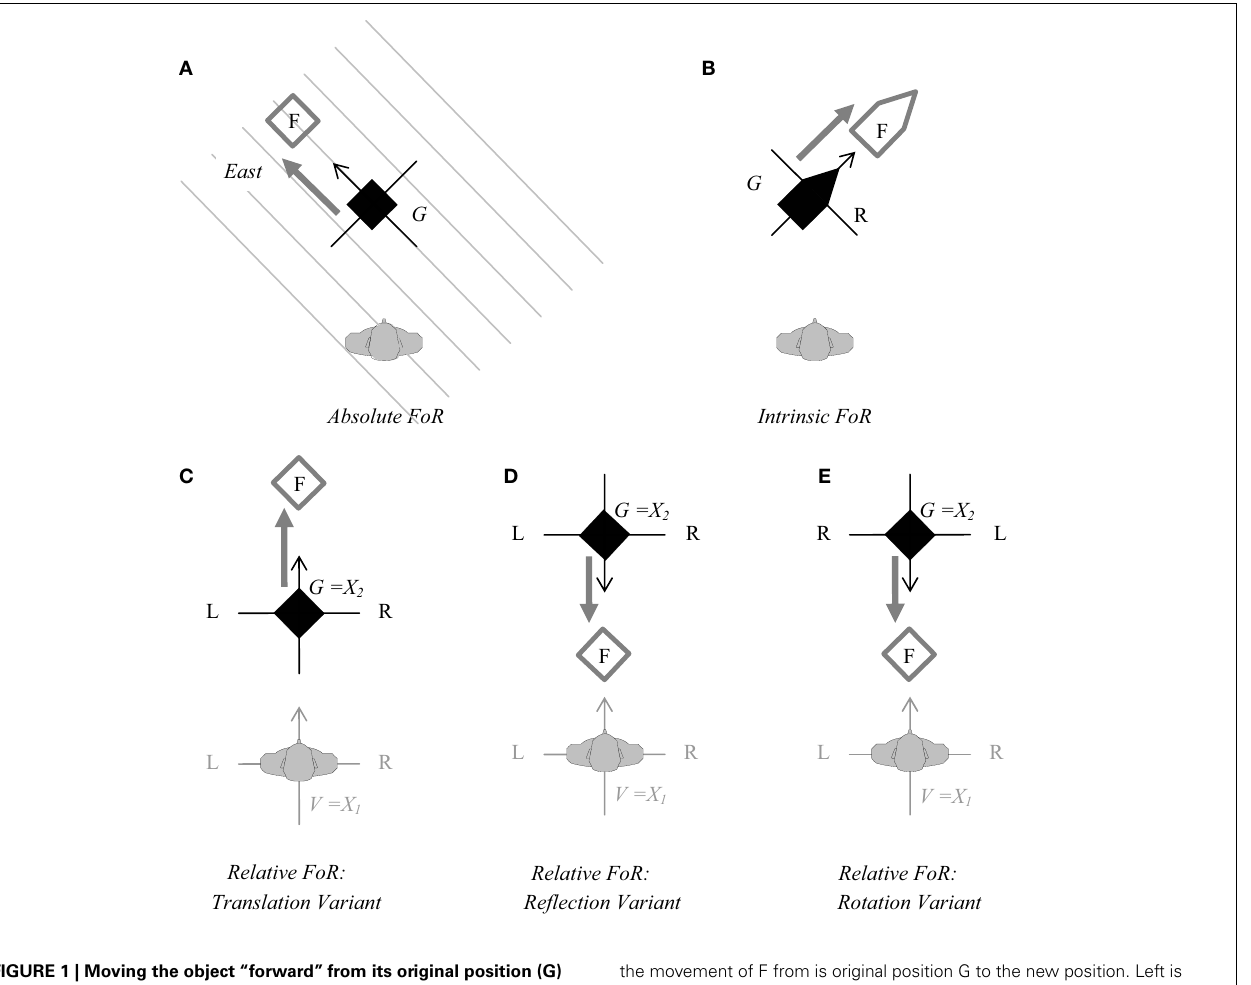
FIGURE 1 | Moving the object “forward” from its original position (G) toward the new position (F) according to different frames of reference (FoRs): the absolute FoR (A), the intrinsic FoR (B), and the three variants of the relative FoR (C), (D), and (E). Note: The array is depicted from above. G is colored black, F white, and the observer gray (gaze direction is indicated by the tip of the nose).The thick gray arrow indicates